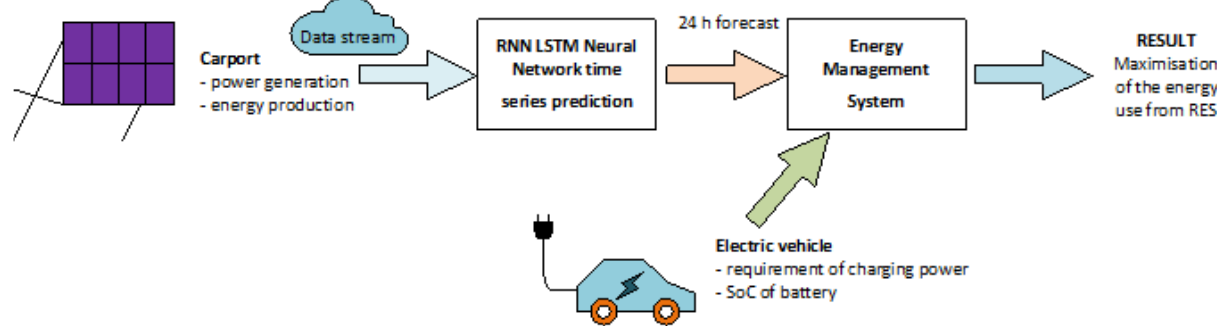
Figure 5: Scheme of an application of deep RNN LSTM neural networks to predict performance of photovoltaic system performance for charging electric vehicle